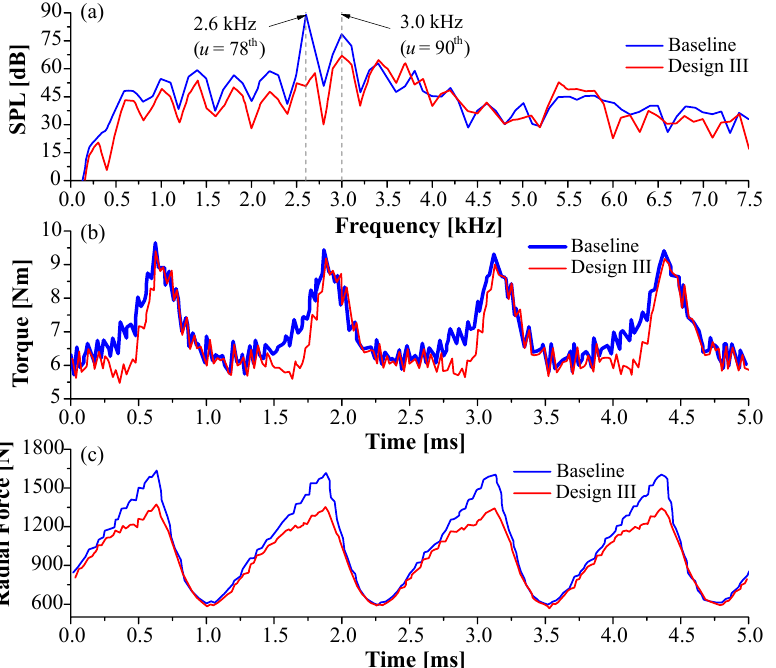
Figure 30. Comparison of performance characteristics of Design III and baseline 8/6 SRM at 2000 rpm: